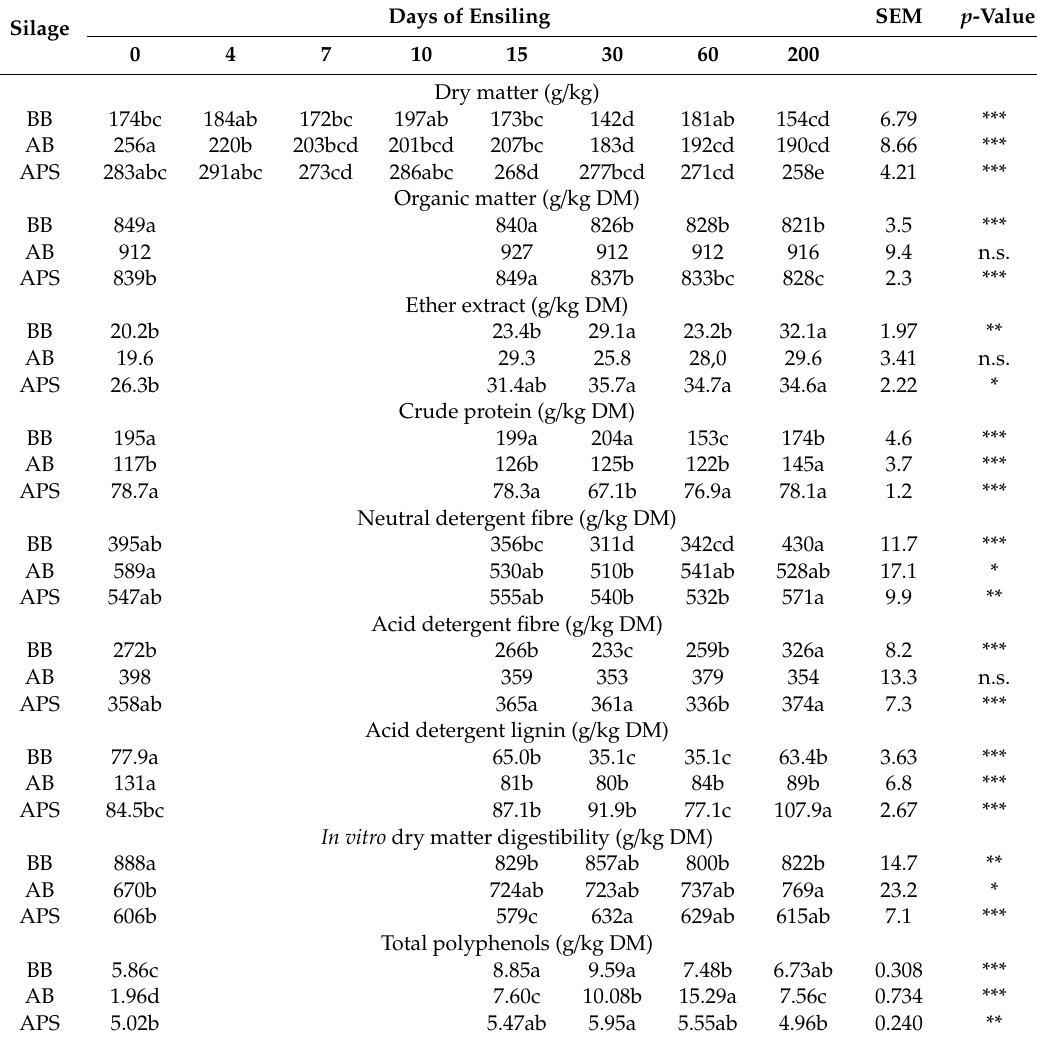
Table 1. E ff ect of ensiling on nutritional composition, in vitro dry matter digestibility and total polyphenols content in broccoli by-product (BB), artichoke by-product (AB) and artichoke plant stubble (APS)